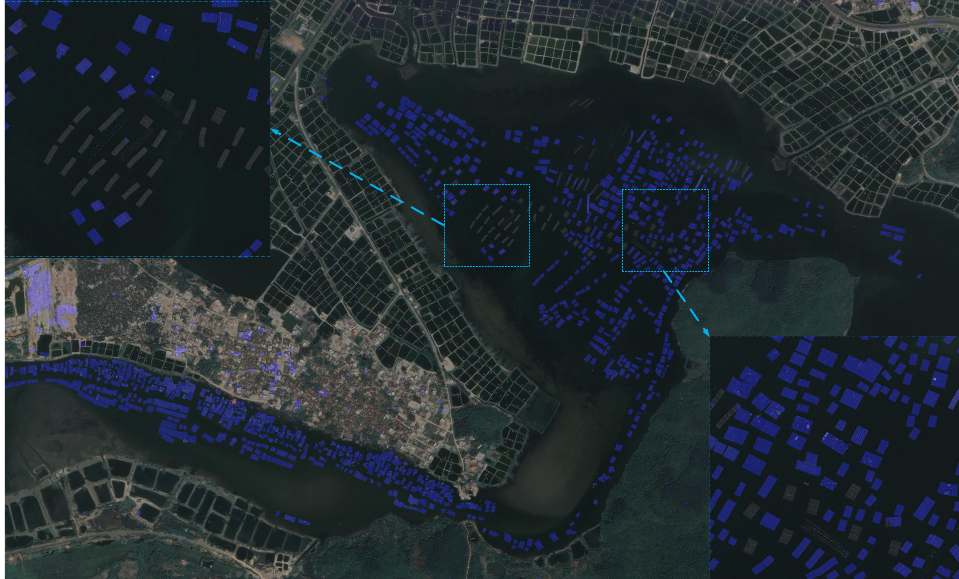
Figure 11. Visualization of the